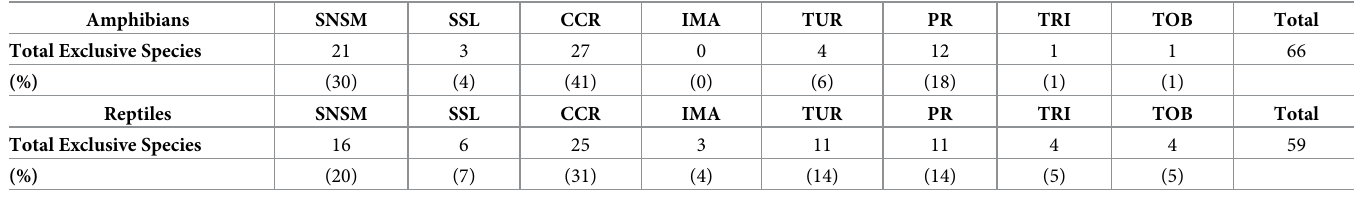
Table 2. Total number of exclusive and restricted species of amphibians and reptiles to humid or evergreen mountain forests in the studied region.